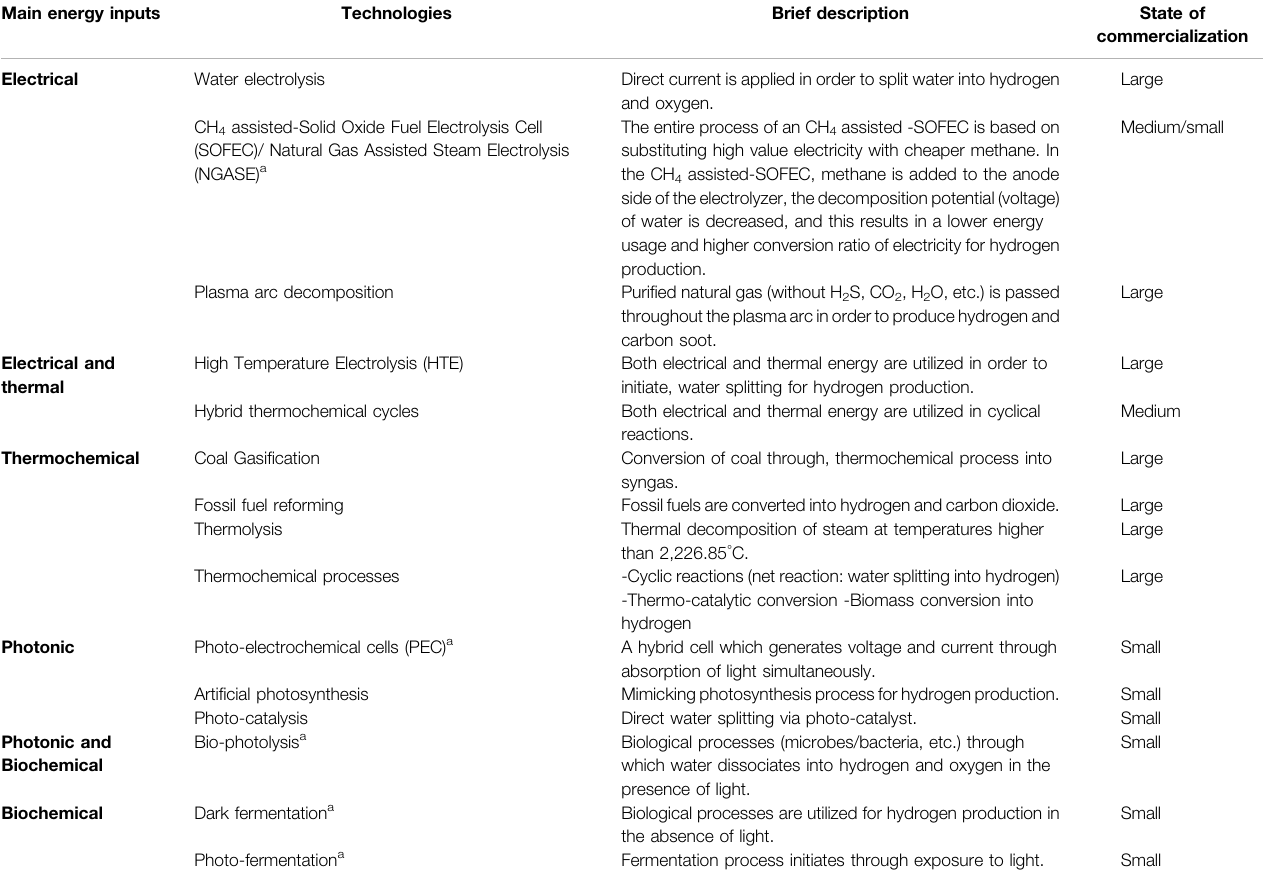
TABLE 2 | A brief description of various hydrogen production processes (Wijers, 2011; Acar and Dincer, 2018). Main energy